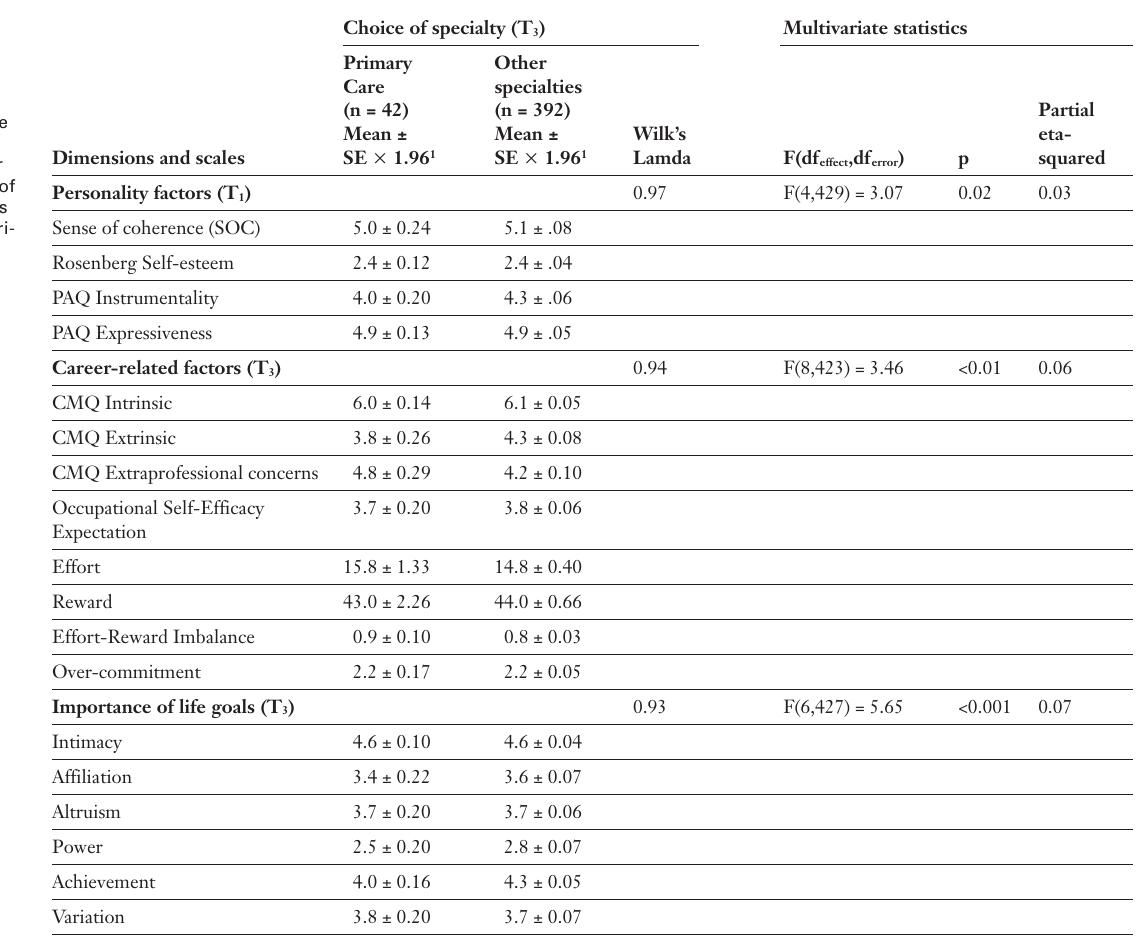
Table 5 Means and Delta crit1 of personality and career-related fac- tors, and importance of life goals in pri- mary care and other specialties. Results of multivariate analysis of covariance (covari- ates: gender, age) (n =